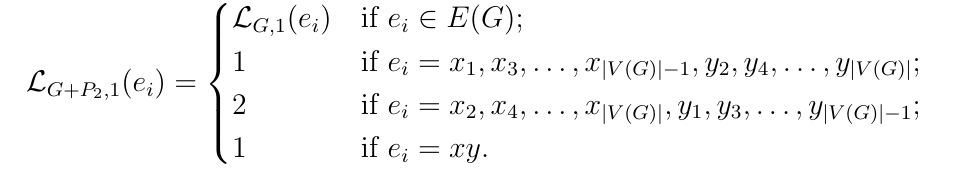
has a Z -magic labeling with magic value 7 3